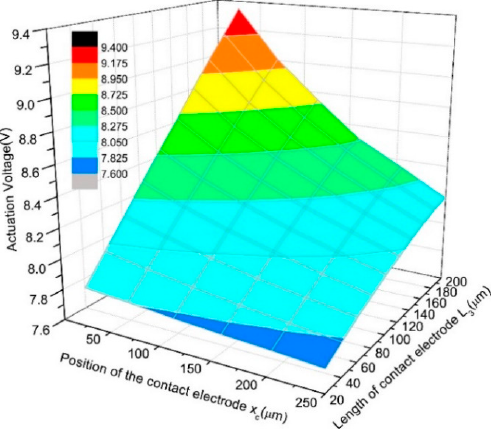
Figure 3. Simulated actuation voltage versus x c and L 3.